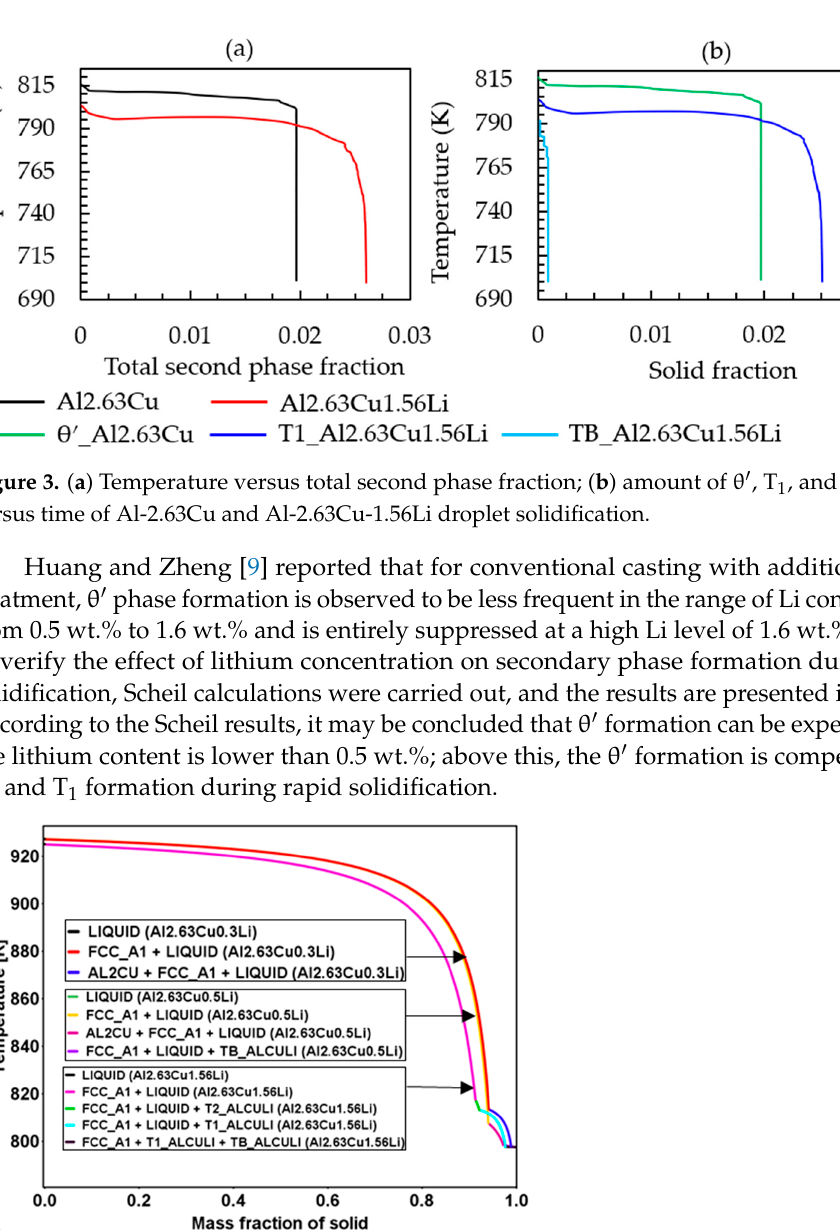
Figure 2. ( a ) Time ‐ temperature cooling curve; ( b ) solid fraction ‐ temperature curve of the Al ‐ 2.63Cu and Al ‐ 2.63Cu ‐ 1.56Li alloys for a constant heat extraction rate of 1.53 × 10 5 Js − 1 cm − 3 .